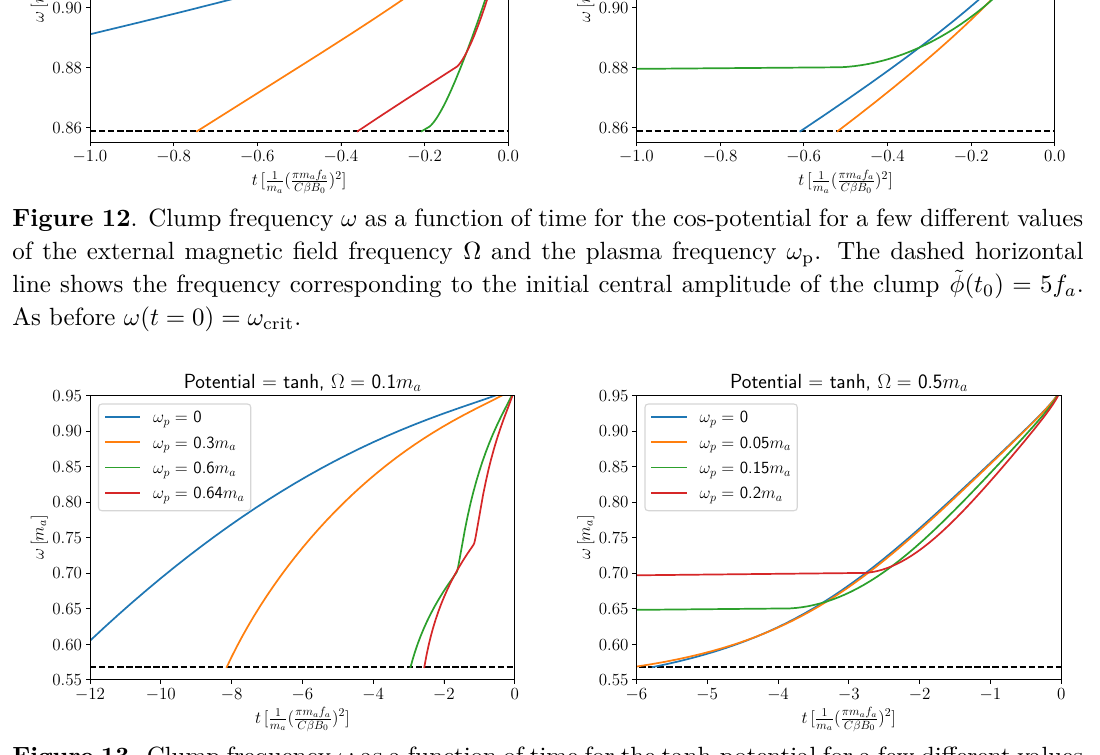
Figure 13 . Clump frequency ω as a function of time for the tanh-potential for a few different values of the external magnetic field frequency Ω and the plasma frequency ω p . The dashed horizontal line represents the frequency corresponding to the initial clump amplitude ˜ φ ( t 0 ) = 5 f a and ω ( t = 0) = ω crit .